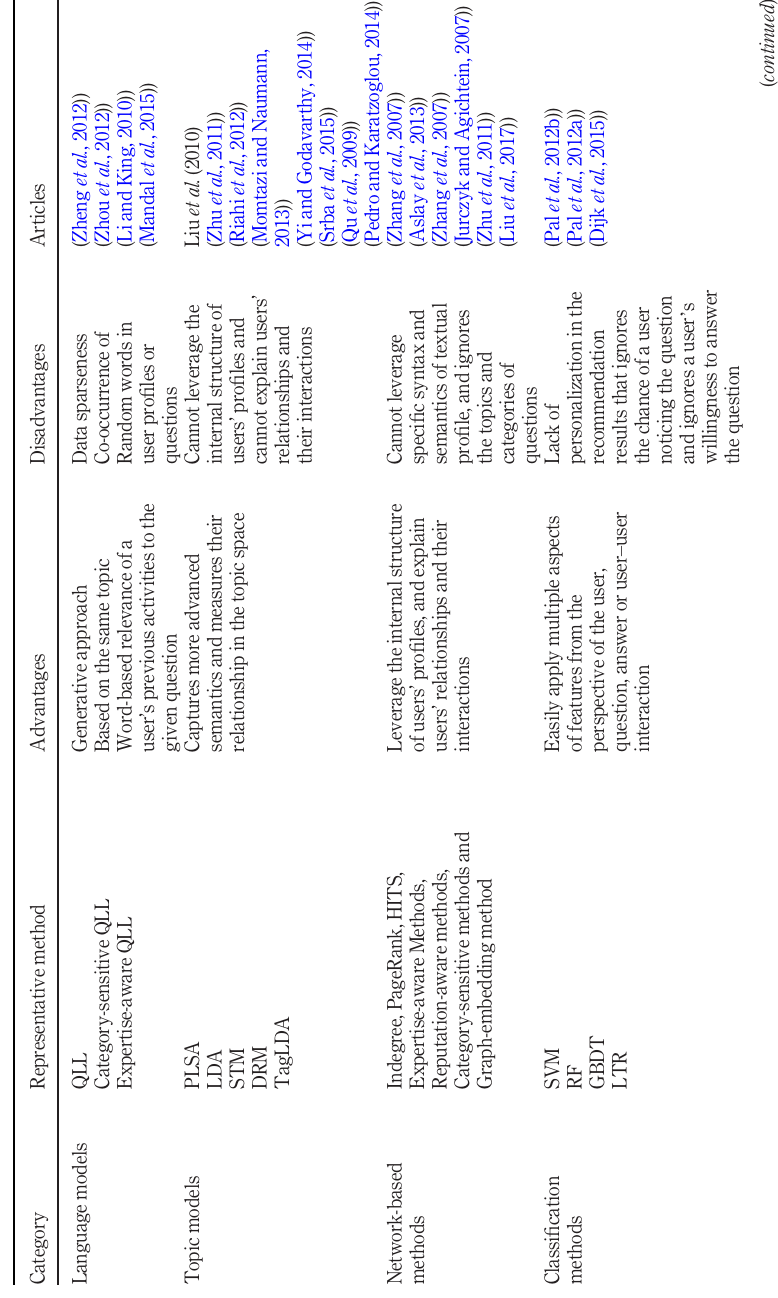
Table III Summary of advantages and disadvantages of expert recommendation